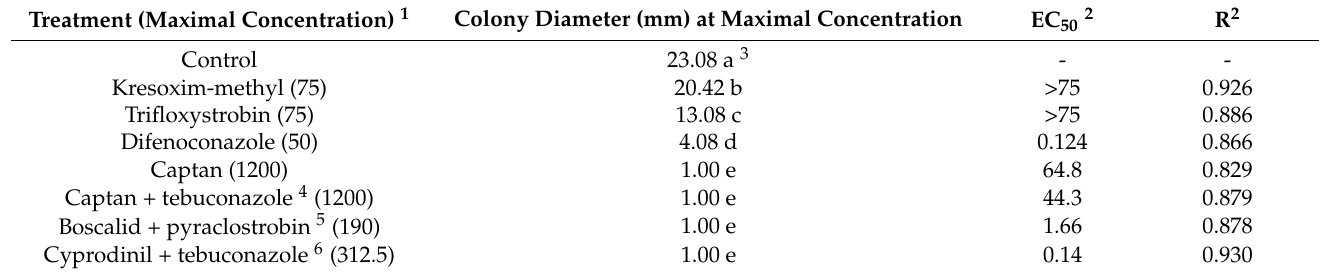
Table 6. Efficacy values EC 50 ( µ g mL − 1 , ai) of fungicides and fungicide mixtures against mycelial growth of V. inaequalis isolate V.i-AL-f.